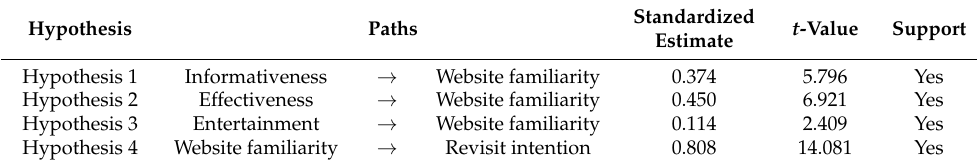
Table 4. Standardized parameter estimates for the structural